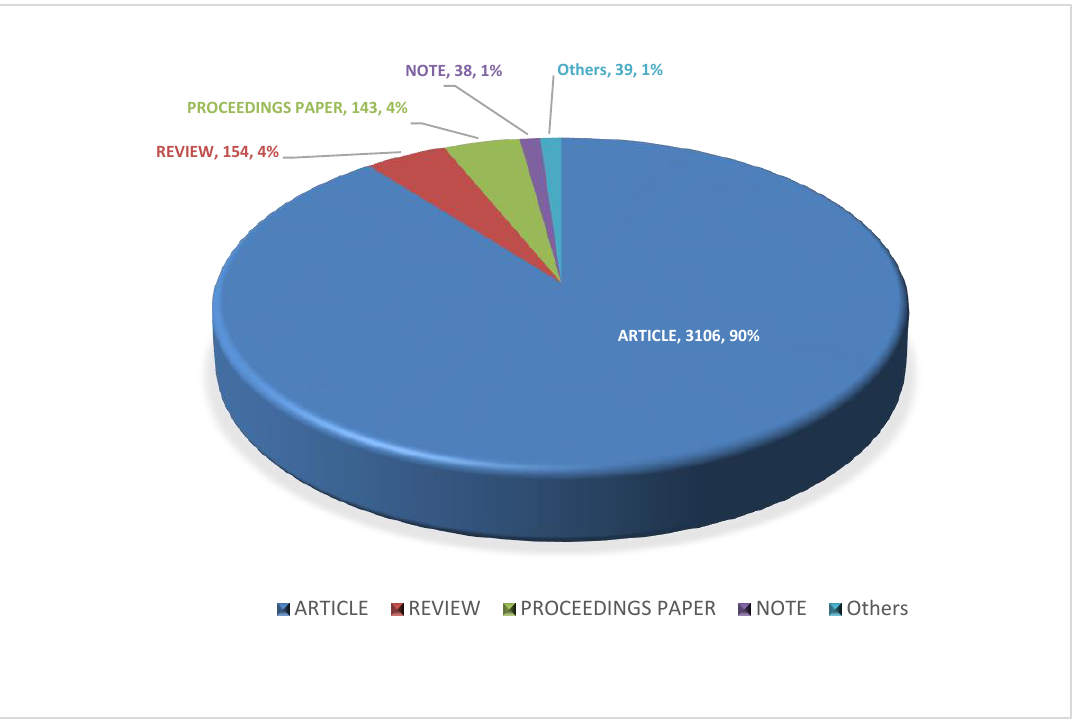
Figure 1. Categorization of solid dispersion publications by documents types from1980 to 2015.